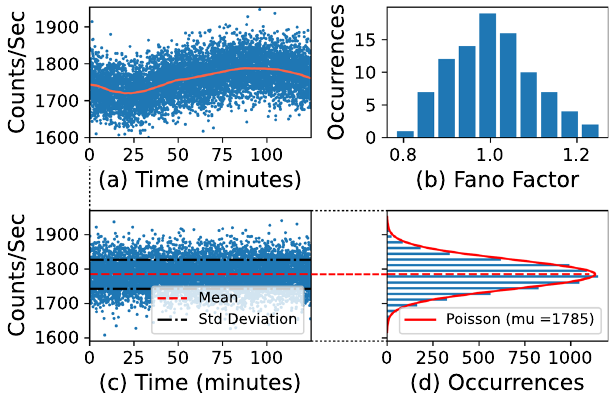
Fig. 6 Analysis of coincidence data obtained in a laboratory setting. a Raw coincident event rate and the moving average of the data points (orange curve) indicate the presence of a low-frequency component to the noise. b Histogram of Fano factors for each segment of 192 seconds length from the raw data in a . It shows that the Fano factors are centered ~1. This implies that in short time intervals the Poisson distribution is preserved. c The same data after removing low-frequency components by Fast Fourier Transform (FFT) fi ltering. d The histogram of the fi ltered coincidence data fi t a Poisson distribution (red curve), indicating the remaining fl uctuations are consistent with shot